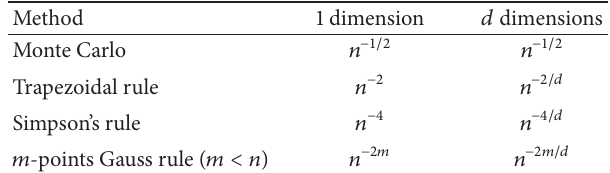
Table 1: Efficiency of integration methods for 1 dimension and for 𝑑